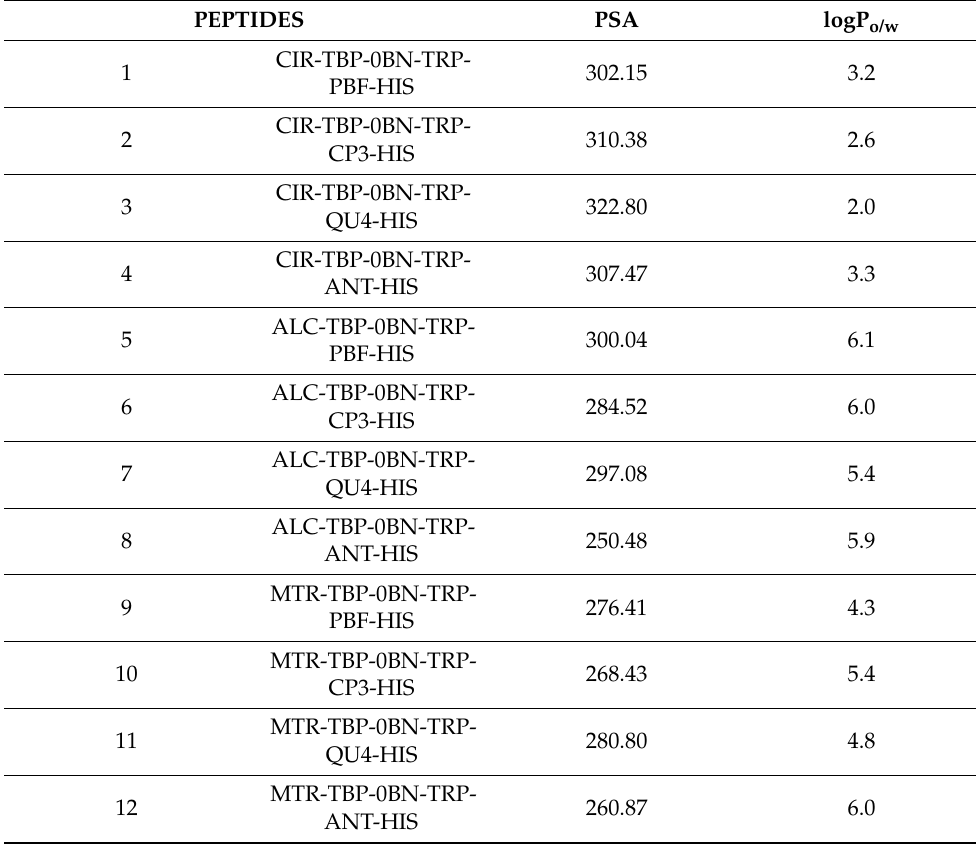
Table 6. PSA and logP o/w values of the twelve combinatorial peptides.